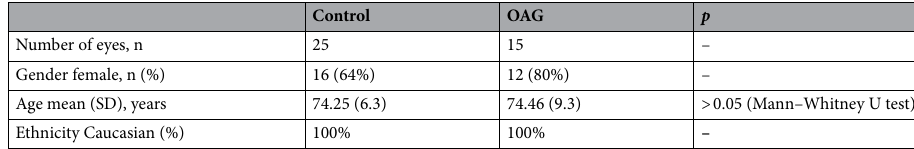
Table 1. Demographic data. The age difference between groups was insignificant, there were more female than male patients in both groups. All of the patients were Caucasian.